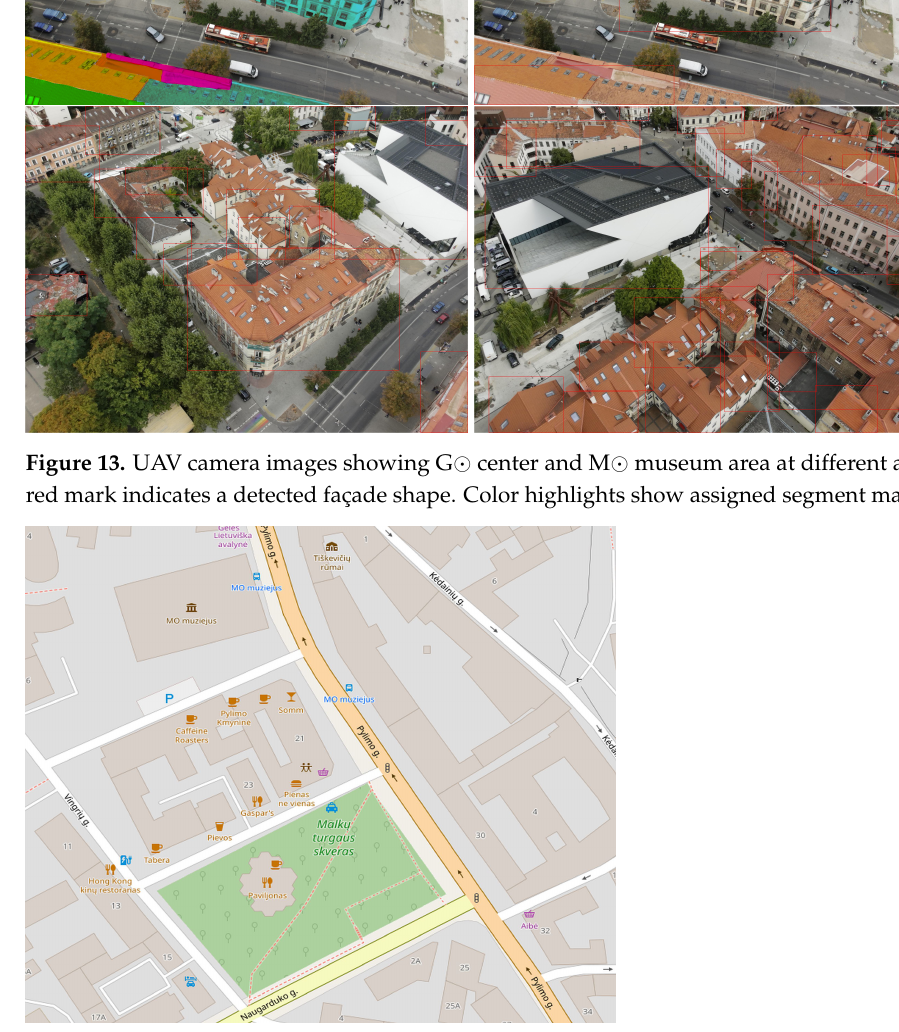
Figure 14. OpenStreetMap building overlay of the G (cid:12) center and M (cid:12) museum area